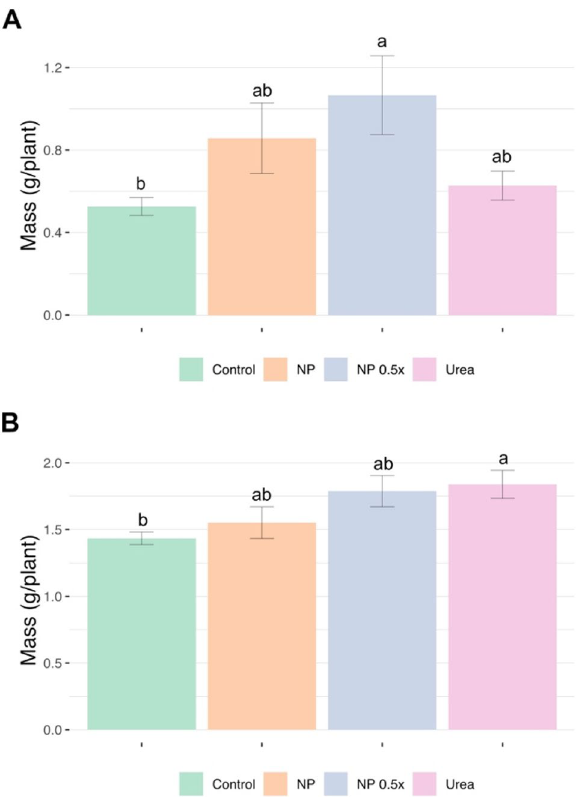
Figure 4. Fresh biomass of roots ( a ) and shoots ( b ) in cucumber plants at 7 days after the treatments. Data are means (± standard error) of five independent biological replicates, ( n = 5). The statistical significance was determined using one-way ANOVA with Tukey post hoc test (P < 0.05). Different letters indicate significant differences among the